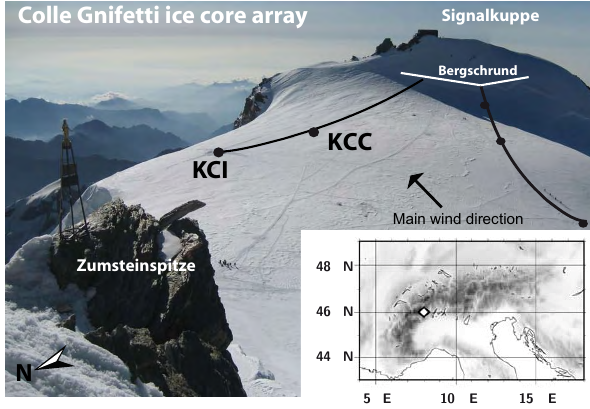
Figure 1. The ice core array at Colle Gnifetti, at 4450ma.s.l. in the Monte Rosa summit range. The drilling sites of the two cores KCI and KCC are located on approximately the same flow line (black line) towards the eastern flank (downwind of the main wind di- rection), hence providing the same upstream catchment area. Loca- tions of previous drillings initiated by the Institute of Environmental Physics are also shown as small black dots for